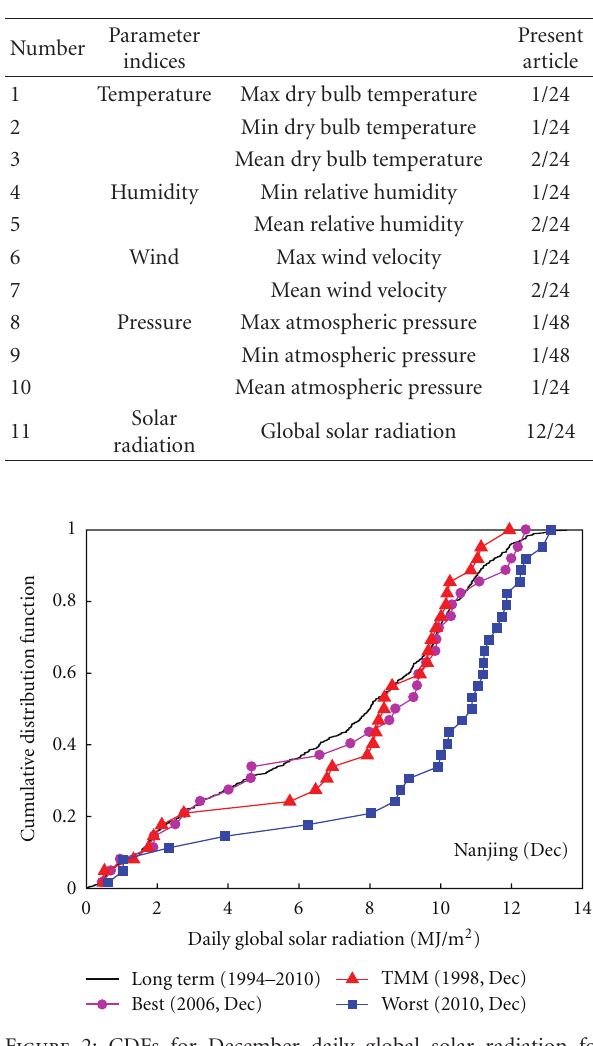
Table 2: Meteorological indices and weighting factors for the FS statistic in this study.